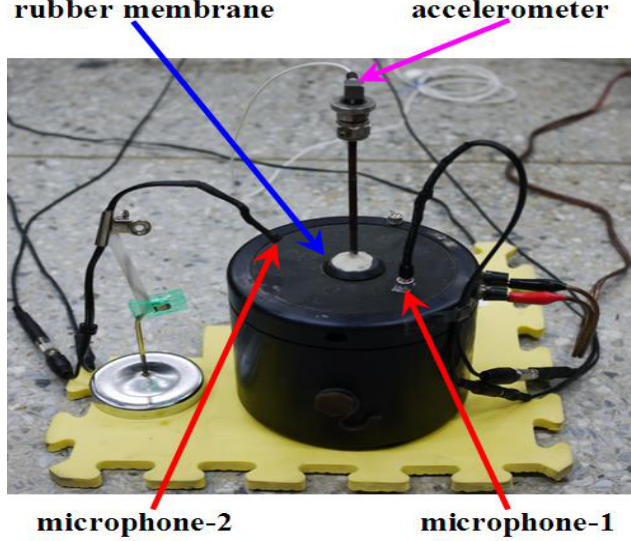
Figure 4. Schematic of the experimental setup of the exciter: the accelerometer is on top of the central bar; microphone-1 is attached to the membrane; and microphone-2 is at 10 cm above the